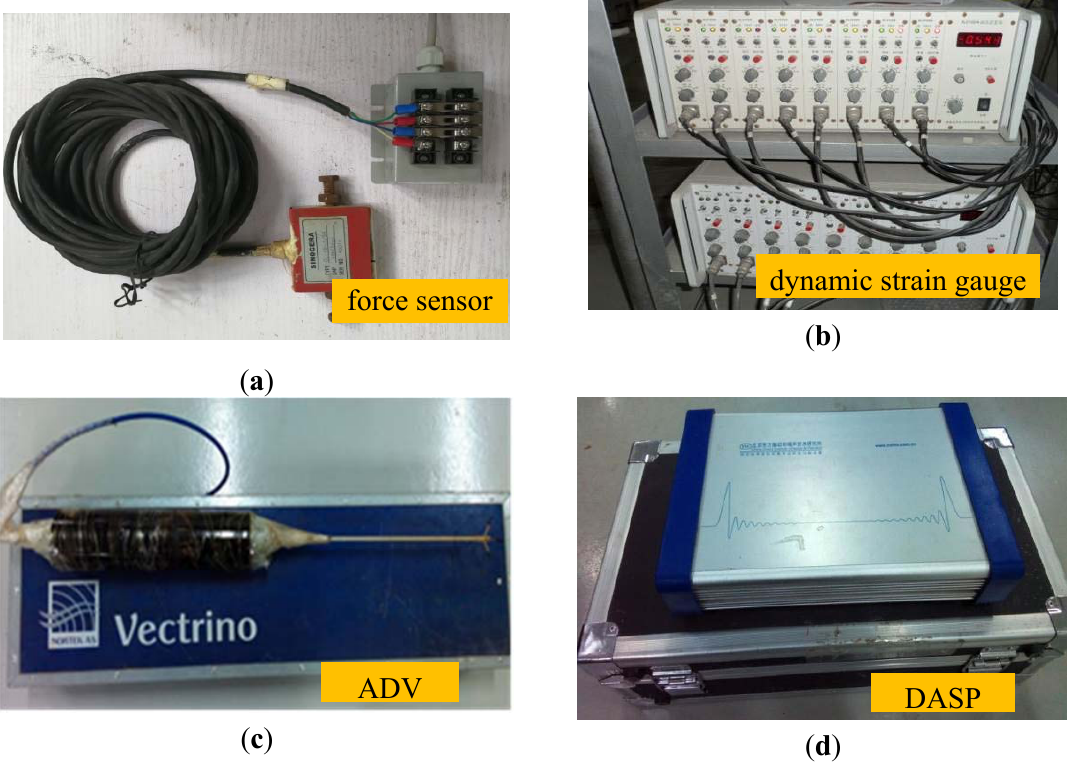
Figure 6. Experimental measuring instruments: ( a ) force sensor; ( b ) dynamic strain gauge; ( c ) ADV; and ( d ) DASP.